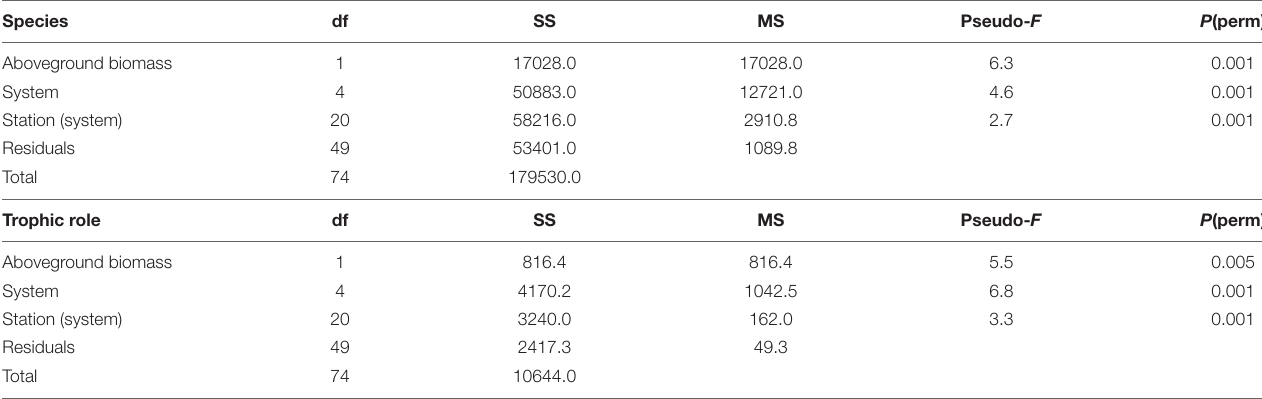
FIGURE 4 | Linear regression of latitude against the total faunal abundance in each of four size classes: (A) 1–2-mm; (B) 2–4-mm, (C) 4–8-mm, (D) > 8-mm. WEE, Weeki Wachee; CHA, Chassahowitzka; HOM, Homosassa; CRY, Crystal River; WAC, Waccasassa. Dashed lines represent the 95% confidence interval of the fitted line (solid line). Colors indicate relative levels of long-term total phosphorus (TP) concentrations in the water column, with lighter colors indicating lower TP. TABLE 2 | PERMANOVA results for community data summarized by species and by trophic